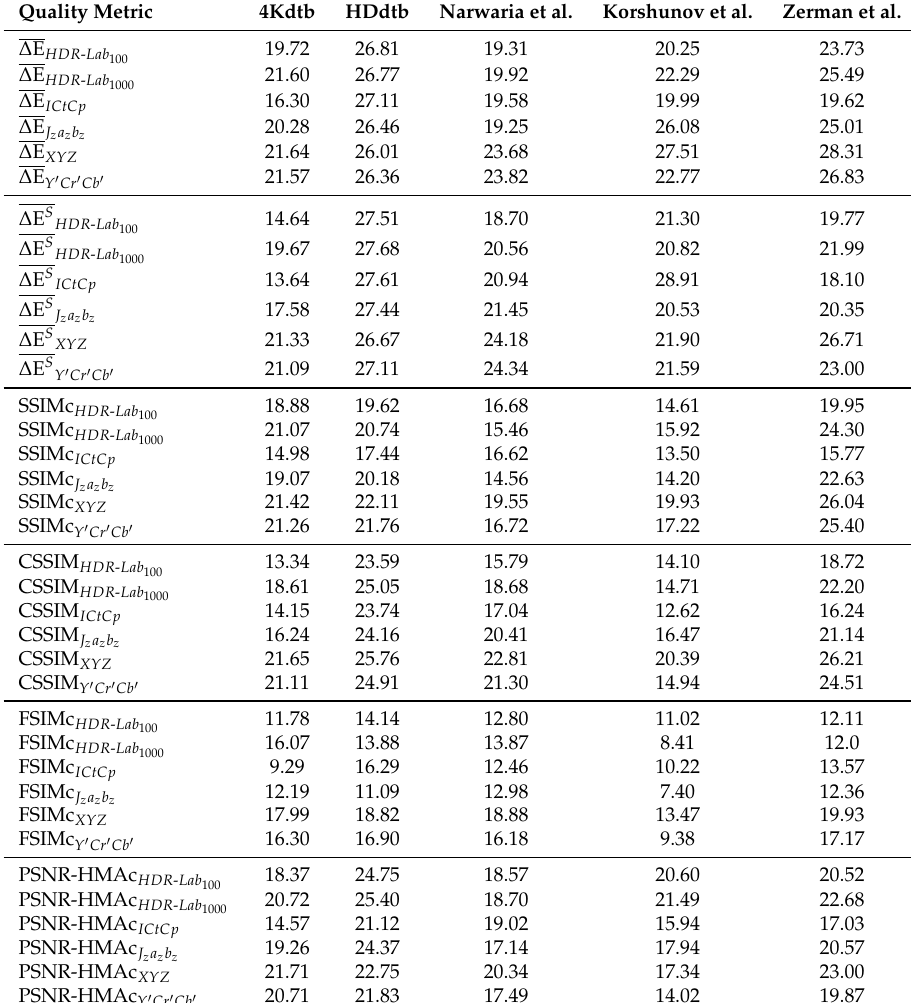
Table A8. RMSE of the different color quality metrics on the considered databases Quality Metric